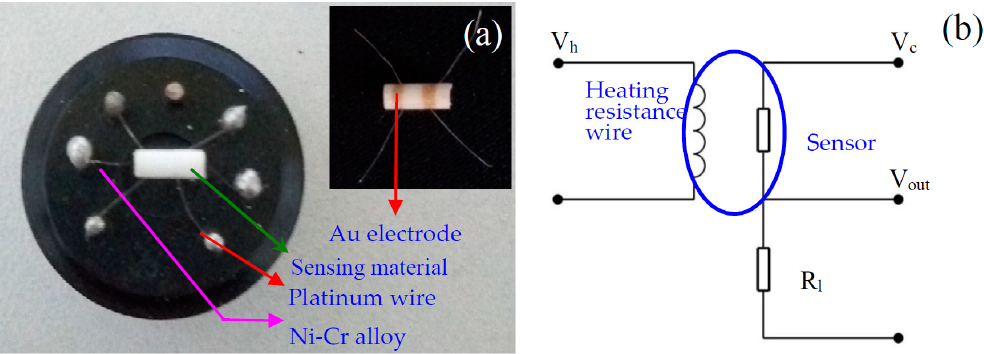
Figure 1. ( a ) Images of the sensor. Inset: alumina tube with two Au electrodes and four Pt wires installed. ( b ) The circuit diagram of the gas-sensing measurement system. installed; ( b ) The circuit diagram of the gas-sensing measurement